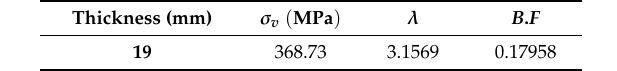
Table 4. Comparison of ANSYS and ISIGHT optimization studies. Parameters